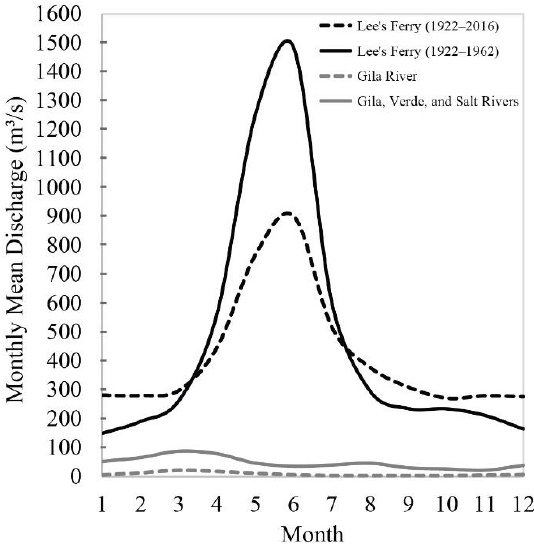
Figure 2. Monthly mean discharge in m 3 /s for Colorado River at Lee’s Ferry (USGS Station 09380000), and Gila River as combining the Gila (USGS Station 09474000), Verde (USGS Station 09510000) and Salt River (USGS Station 09497500). All data are available online from